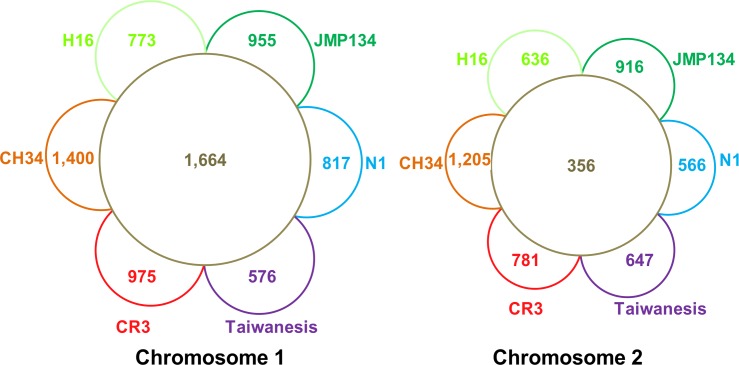
Comparative analysis of gene distribution in two chromosomes.Inner ring shows the number of ortholog gene clusters that are shared by all species based on PGAP result. Outer semi-ring shows the number of ortholog gene clusters that are unique to one strain based on PGAP result. Abbreviation: CR3, C. gilardii CR3; CH34, C. metallidurans CH34; H16, C. eutropha H16; JMP134, C. pinatubonensis JMP134; N1, C. necator N1; Taiwanesis, C. taiwanesis.